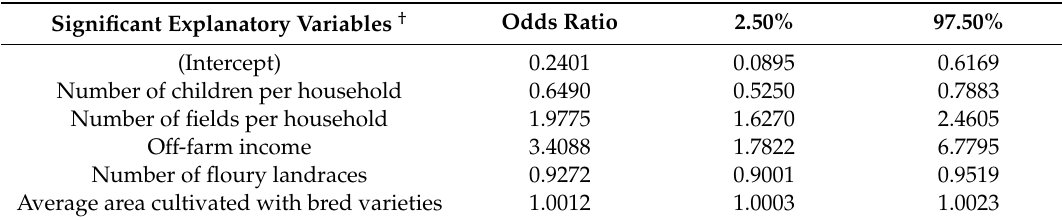
Table 4. Logistic regression output (best model) of most significant di ff erentiating household characteristics between the Huancavelica and Pasco